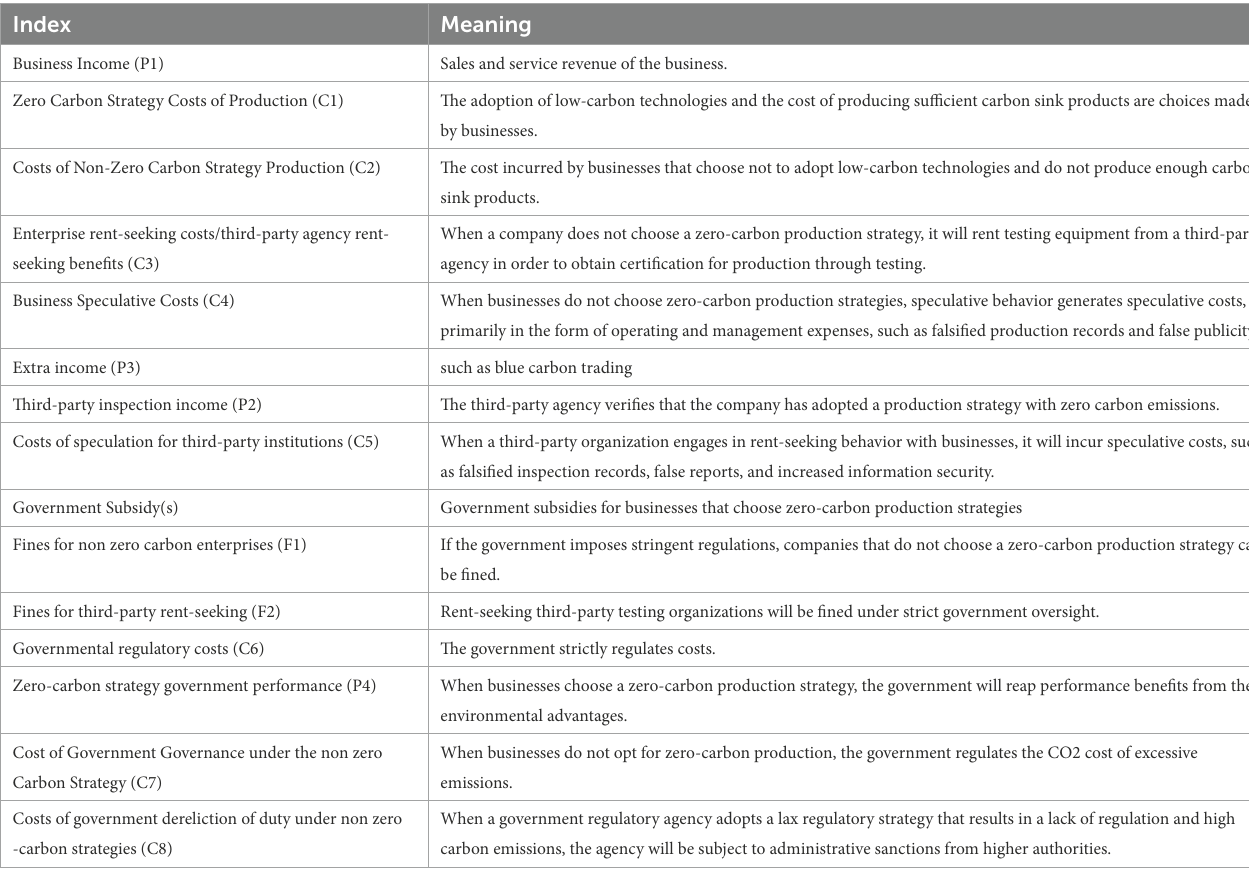
Table 1, this paper advances the following hypotheses regarding the game process of enterprise production eco-efficiency